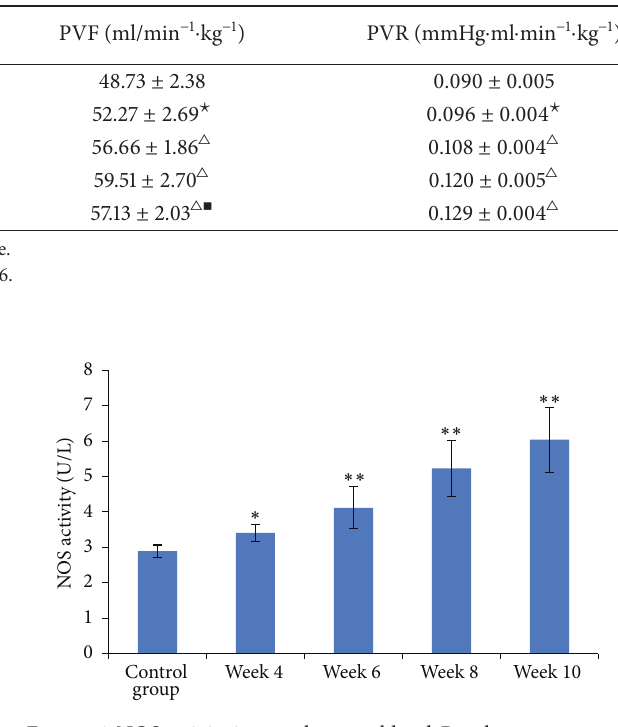
Figure 2: Shear stress measurements and comparison between the groups. Results are expressed as means ± SD, ∗∗ 𝑃 < 0.01 .